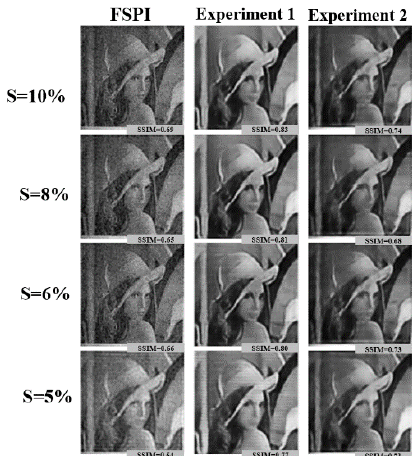
Figure 11. Comparison of reconstruction results for basic FPSI and DL-FSPI methods (experiment 1 and 2).